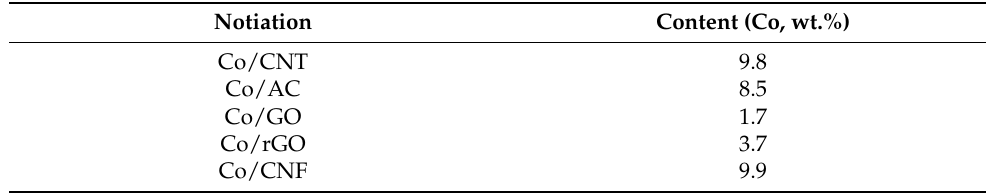
Table 1. Inductively coupled plasma (ICP) results of as-prepared catalysts.